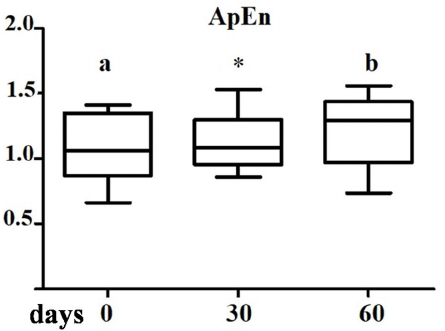
Figure 8. Comparison between the means of the indexes, as a function of days, regarding the Approximate Entropy (ApEn) value, before and after rhinoplasty surgery. Different letters (“a” and “b”) along the one of the columns indicate significant difference at 5% level. Asterisks (*) along the same line indicate no statistical difference at the 5% level.